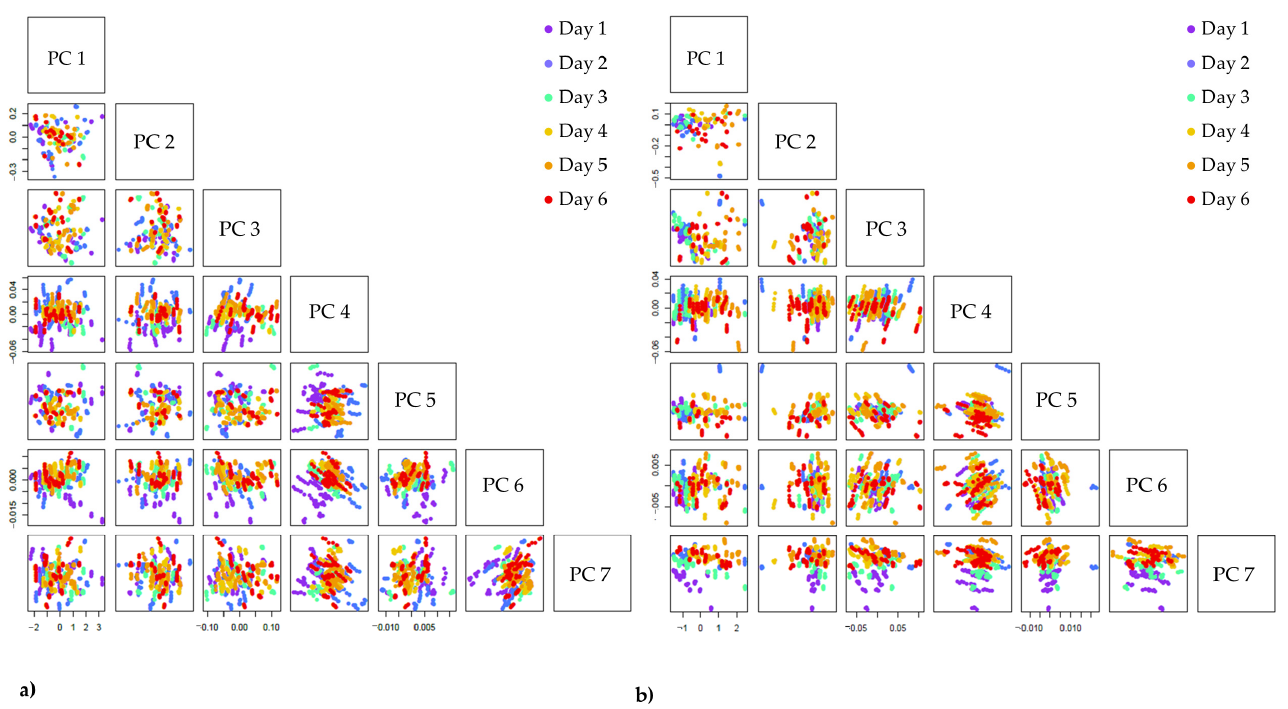
Figure 7. The score plots of PCA analyses performed using the raw data of ( a ) inner leaves (N = 450) and ( b ) outer leaves (N = 450). The scores are colored according to the number of days spent in cold storage.